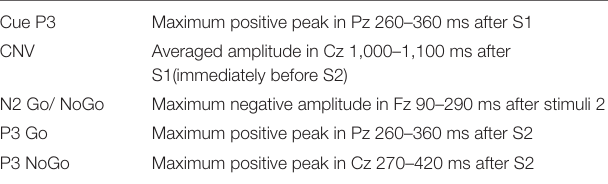
TABLE 2 | Electrophysiological measures,